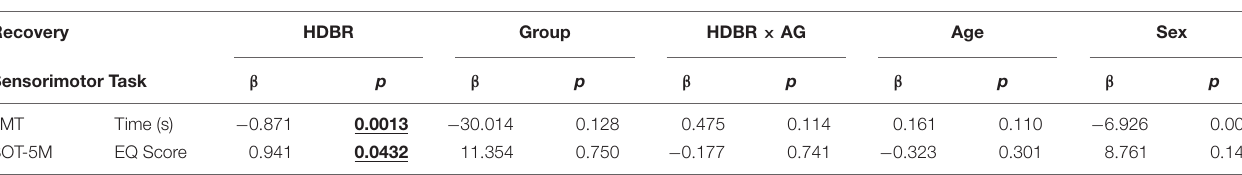
TABLE 2 | Recovery from HDBR + AG environments.